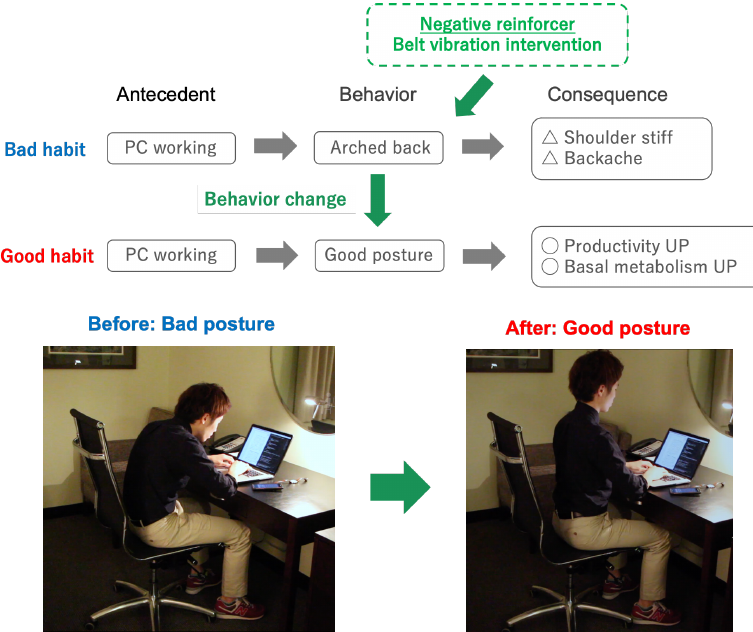
Figure 15. Assumed behavior change scenario (sitting posture improvement).